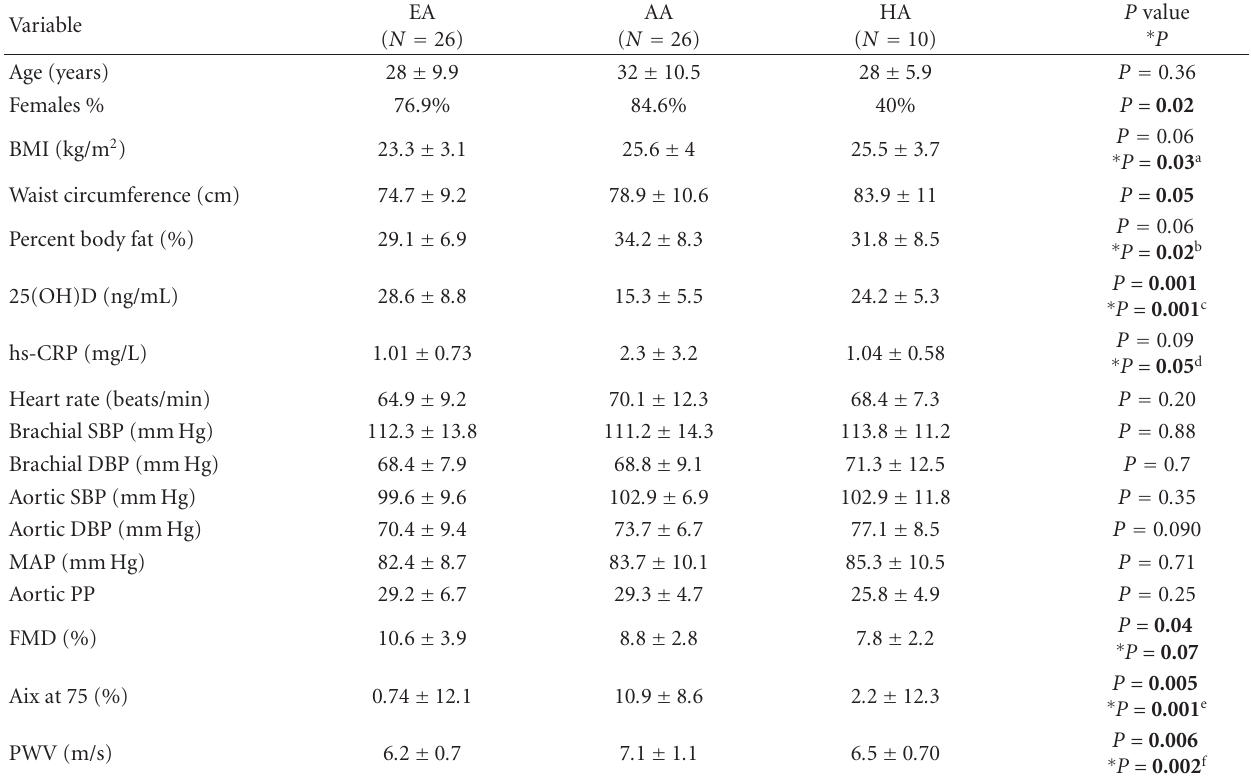
Table 1: Descriptive statistics and outcome variables by race in young